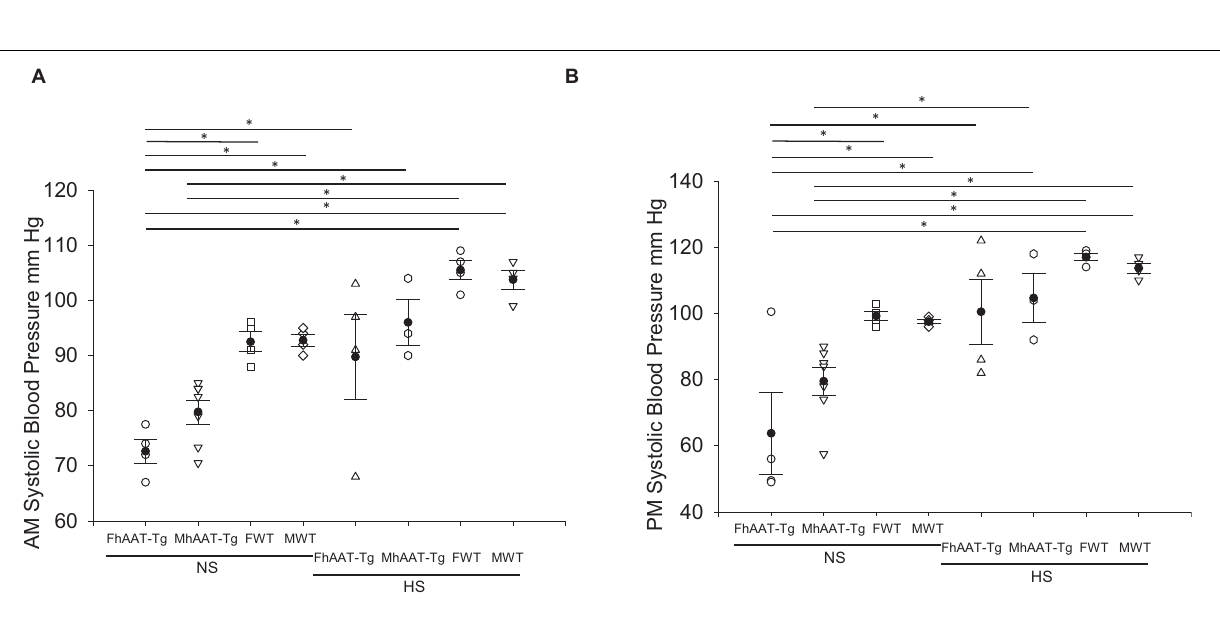
Frontiers in Physiology |